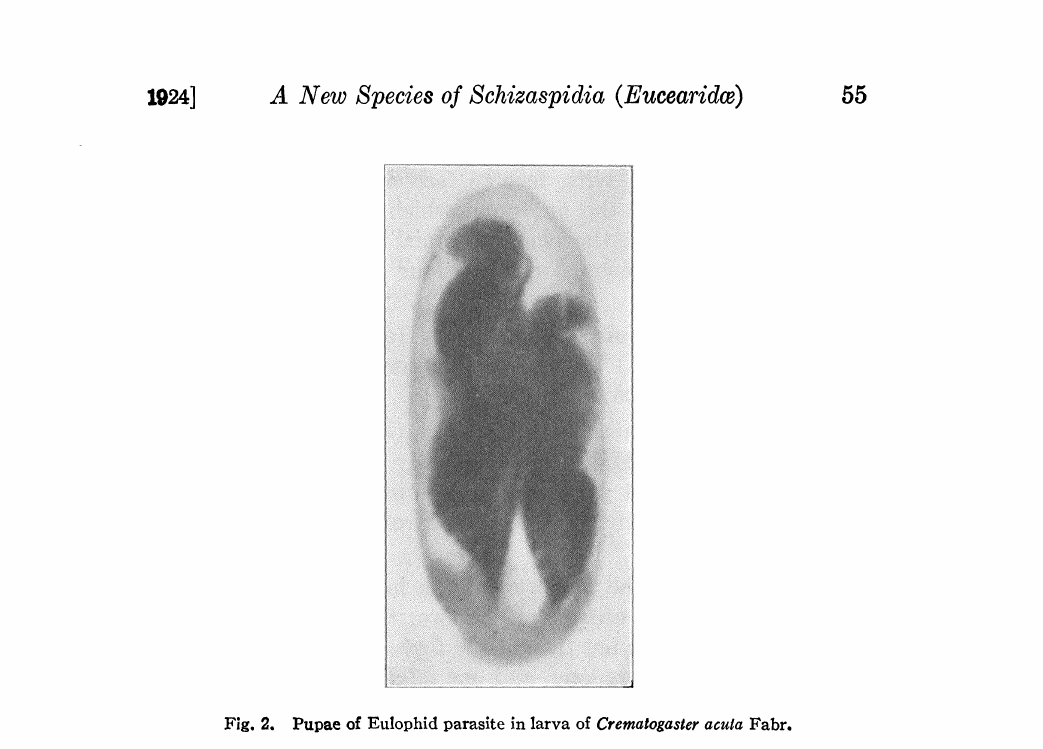
Fig. 2. Pupae of Eulophid parasite in larva of Crematogaster acuta